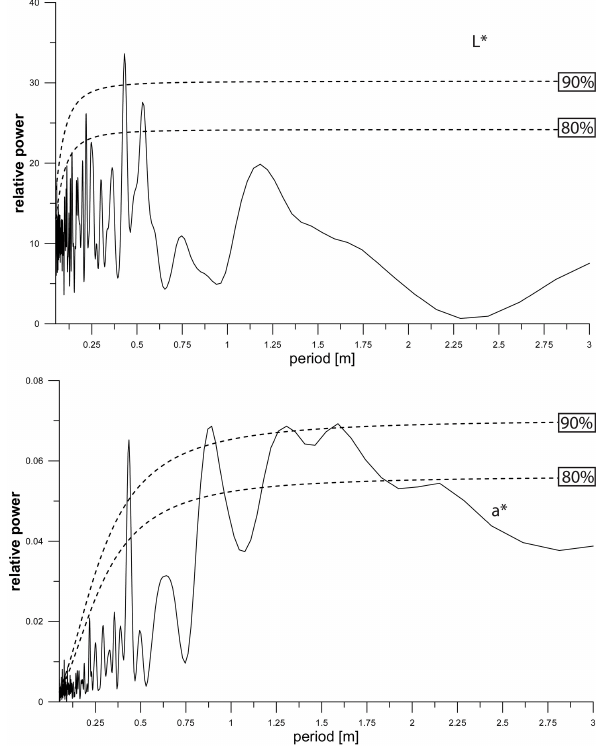
Figure 4. Lomb–Scargle periodogram of L ∗ and a ∗ long records including 80 and 90% confidence